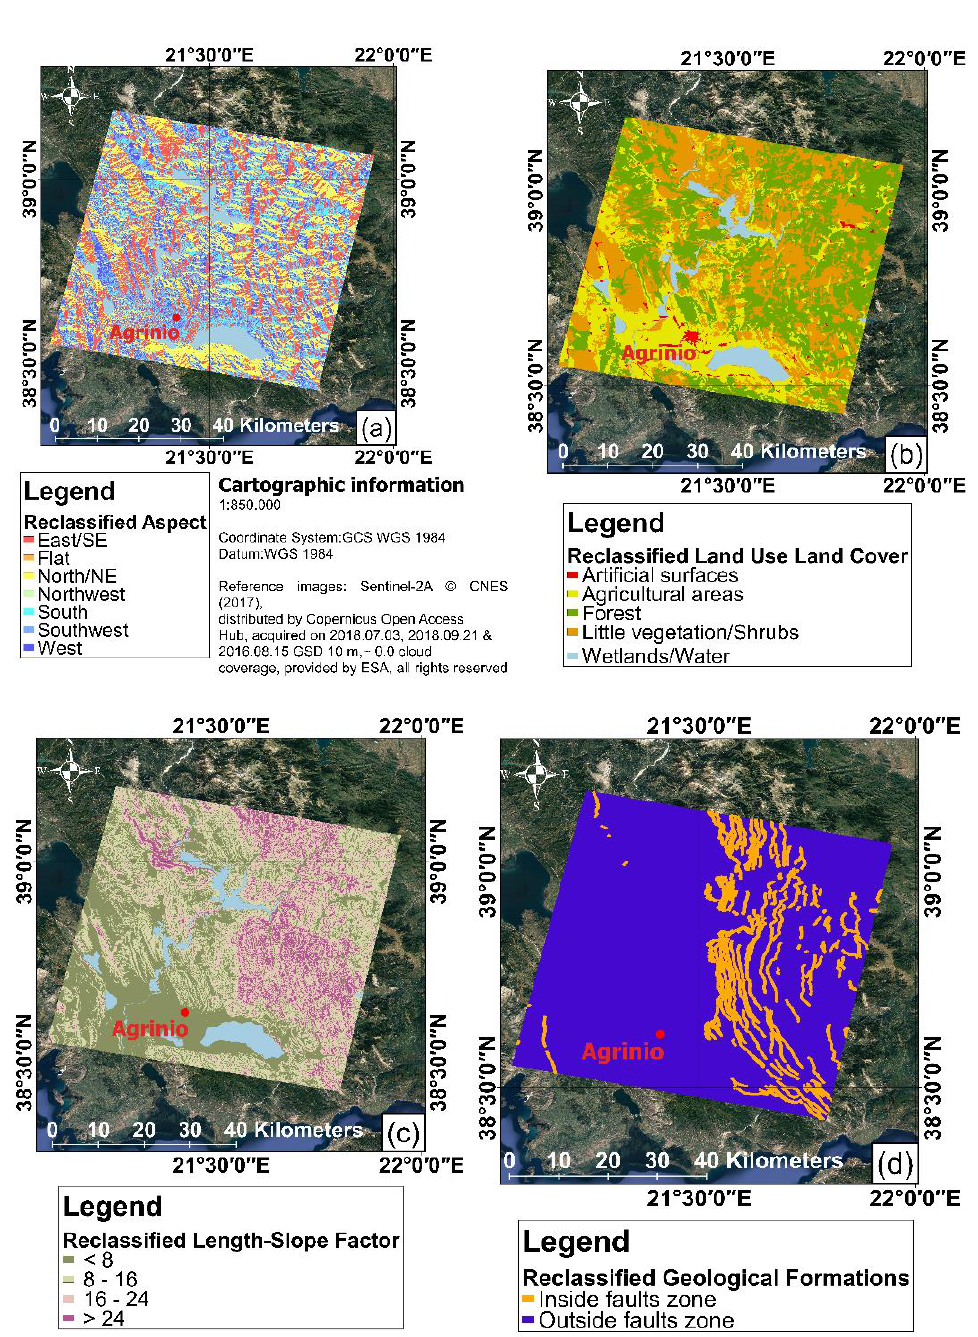
Figure 10. Reclassified layers ( a ) aspect; ( b ) land use land cover; ( c ) length – slope factor; ( d ) faults. The reference image, the coordinate system, and datum information of all maps are provided in map ( a